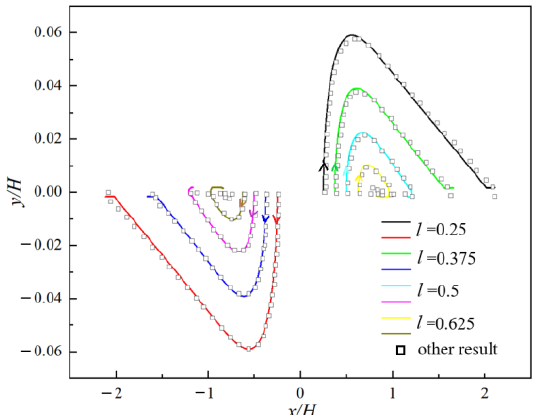
Figure 3. Comparison of trajectories of two analytical solutions of velocity profile, particles in a simple shear